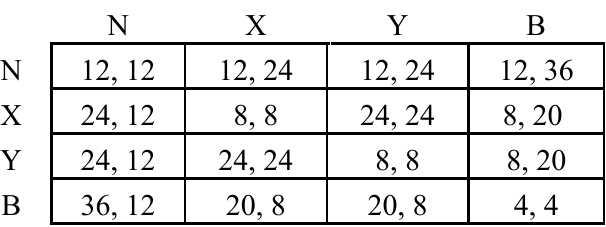
Figure 1. The coordination game in the